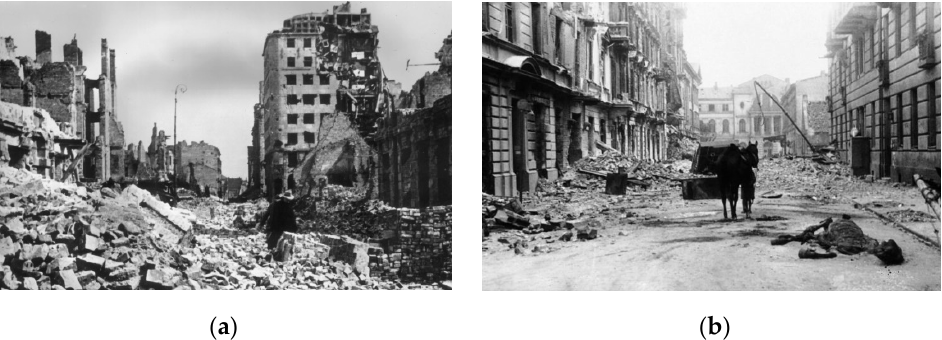
Figure 2. Photos showing the post-war destruction images. ( a ) Nazi plans for the total destruction of Warsaw. Source: [12]. ( b ) Destroyed street in Warsaw after Nazi air raids. Source: [13].